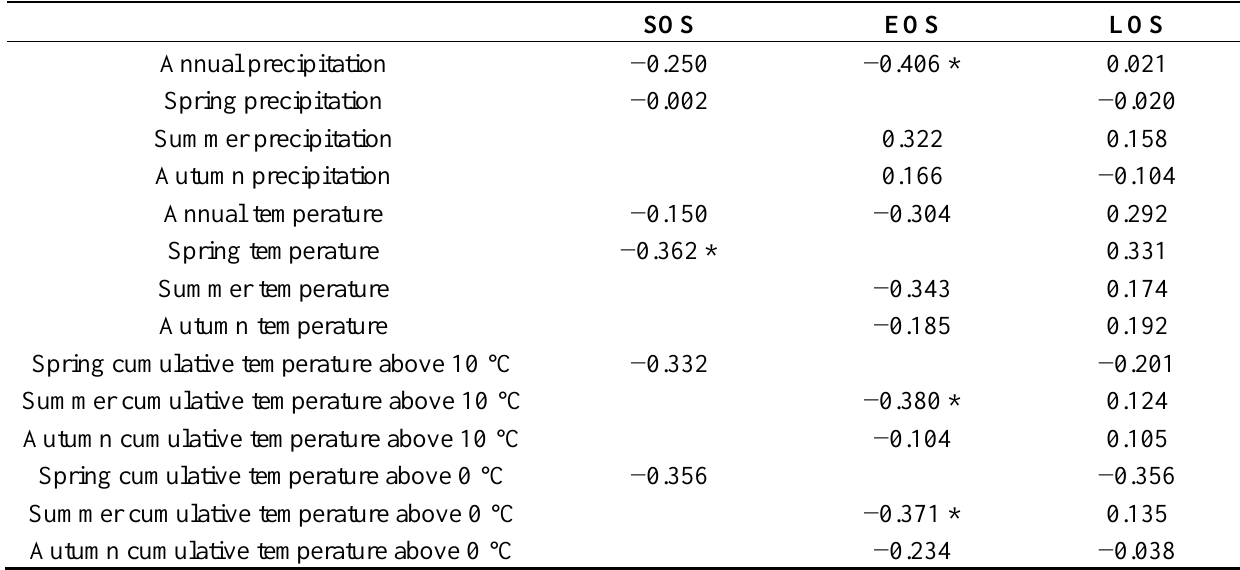
Table 4. Correlation coefficients between phenological parameters and climatic factors in the agricultural